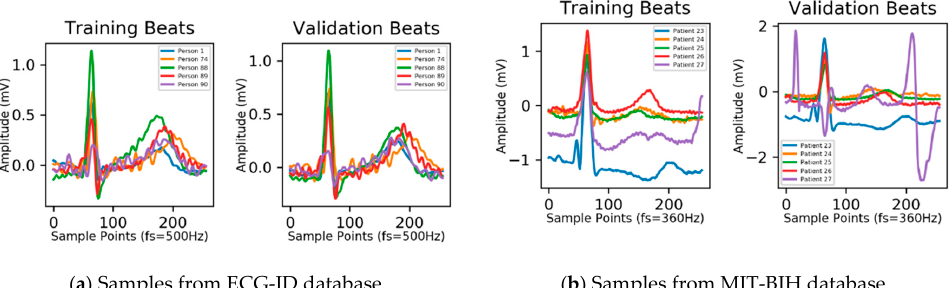
Figure 3. Sample of detected and segmented ECG beats for training and validation.